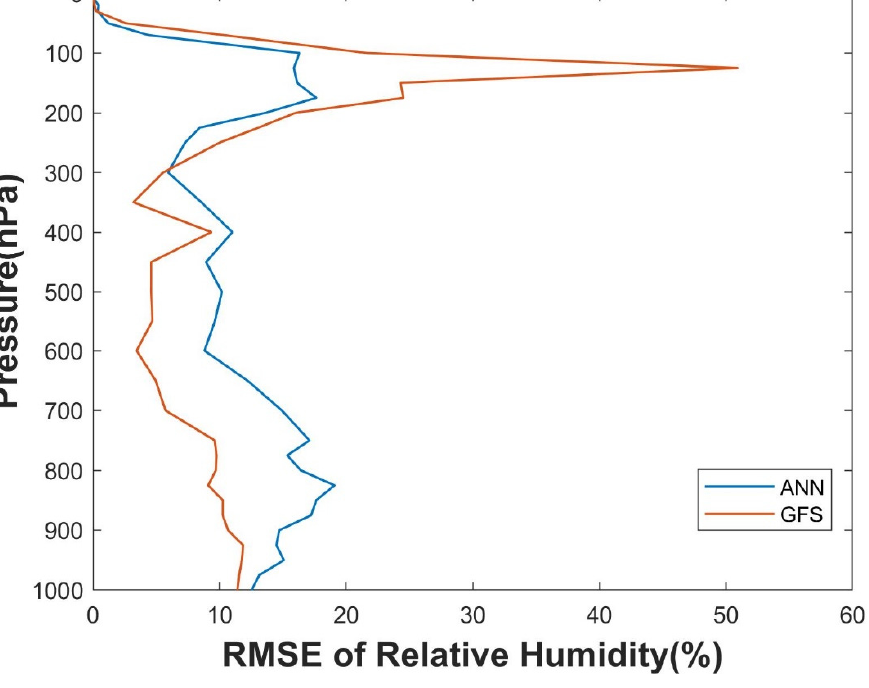
Figure 5. RMSE of ANN and